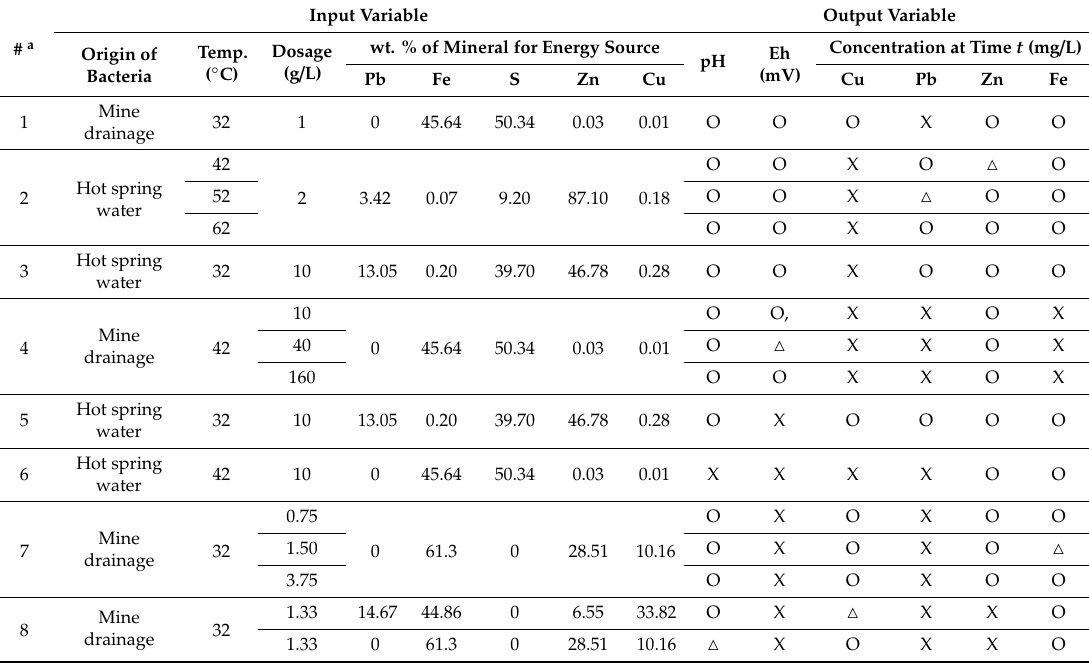
Table 2. Input and Output variables comparison from previous